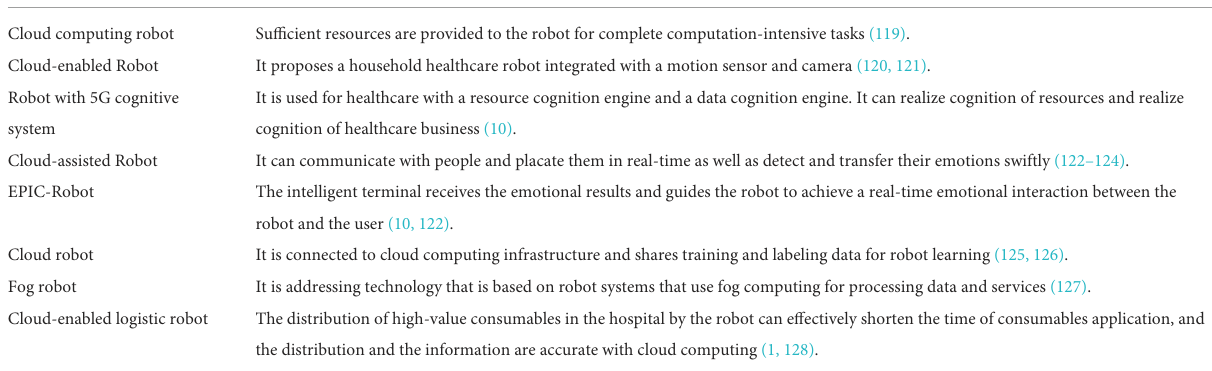
TABLE 4 Smart healthcare with 5G + cloud